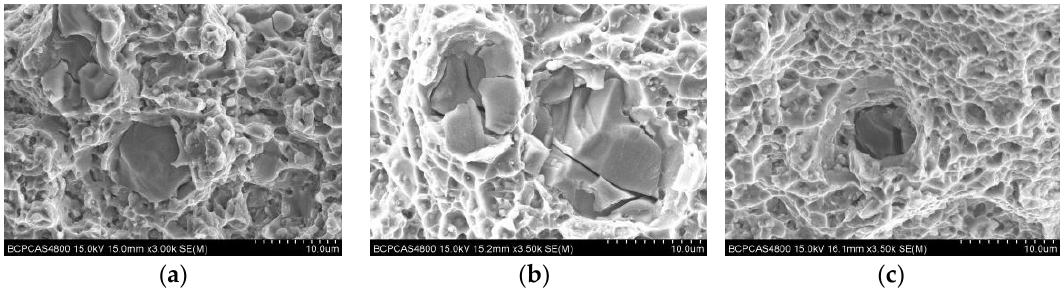
Figure 2. SEM images of TiC/TMCs composites: ( a ) 300 °C; ( b ) 560 °C; and ( c ) 650 °C.